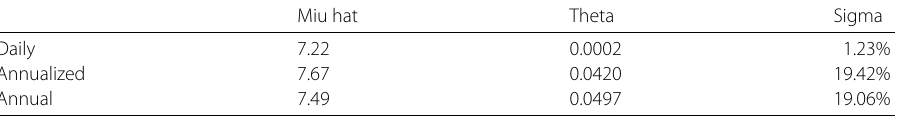
Table 3 Parameters of the exponential Ornstein–Uhlenbeck process obtained for the gold spot price through the maximum log-likelihood method Miu